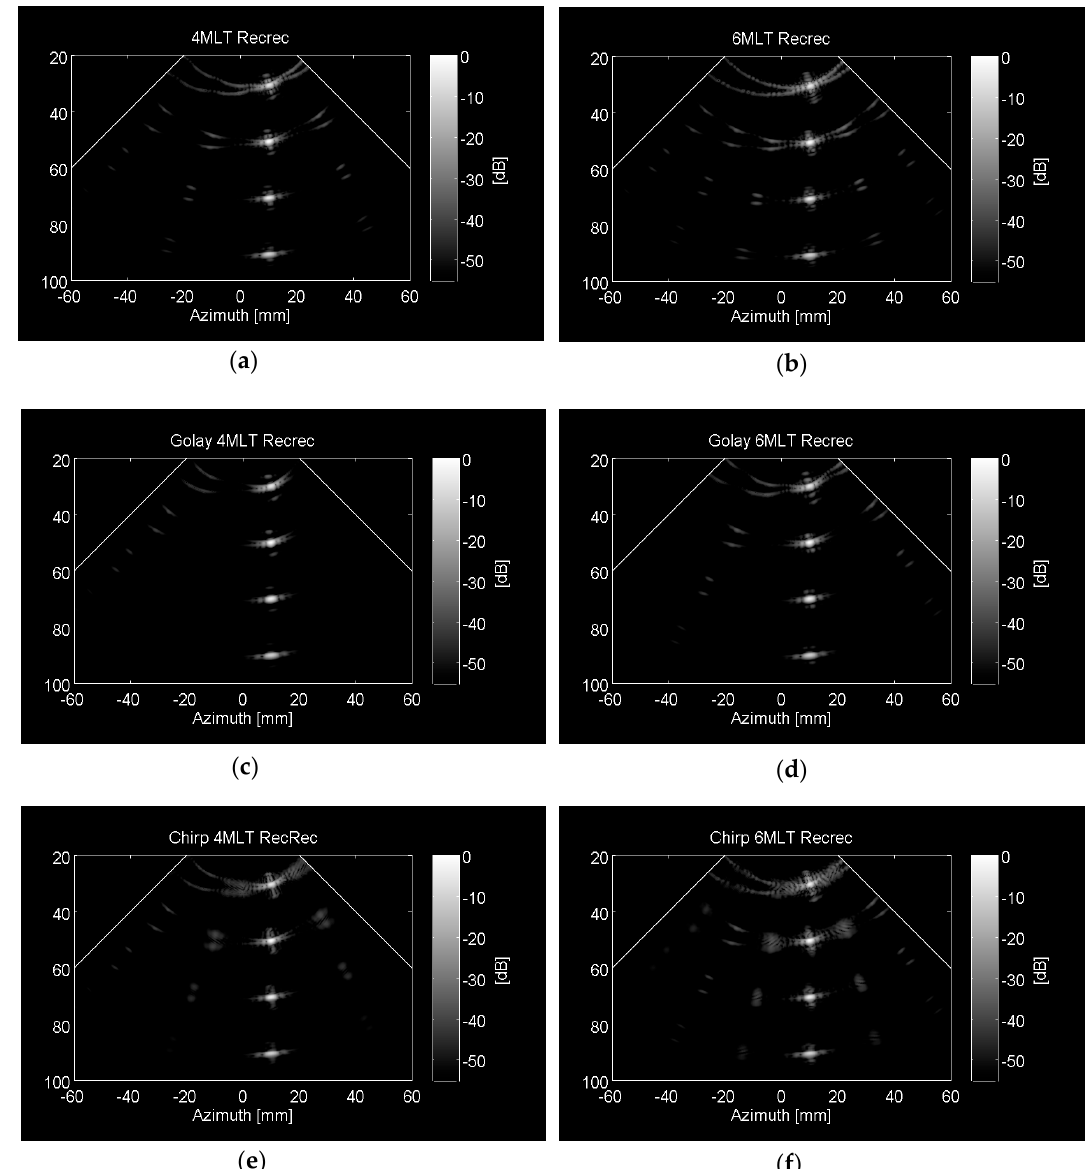
Figure 7. Point-spread-function (PSF) of 4MLT and 6MLT schemes using ( a ), ( b ) non-coded excitation; ( c ), ( d ) Golay coded excitations; and ( e ), ( f ) chirp coded excitations. No apodization was applied on transmit and receive. Crosstalk artifacts appeared and became more severe as increasing the MLT beams.